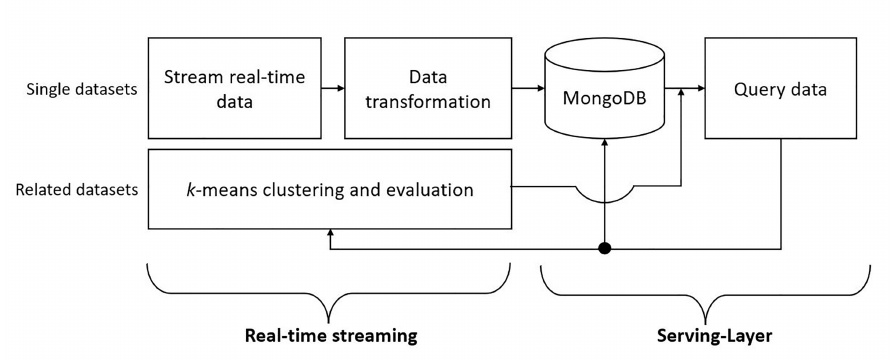
Figure 2. Process diagram for the proposed kappa architecture. Source: compiled by authors .